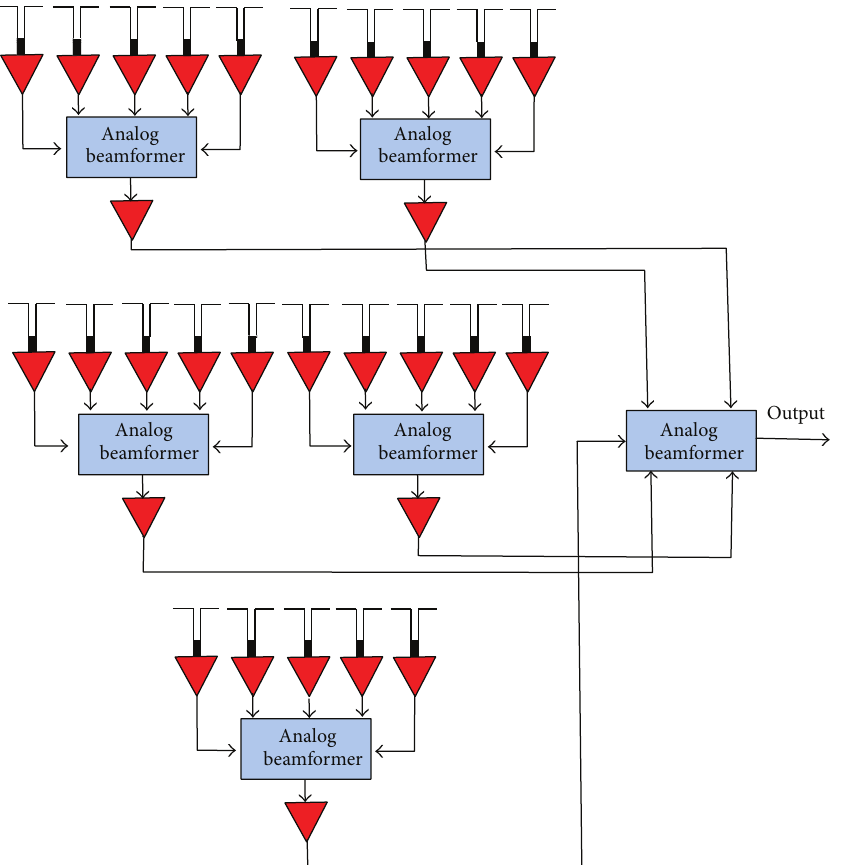
Figure 2: Block diagram of the active antenna array in one polarization. Red triangles denote